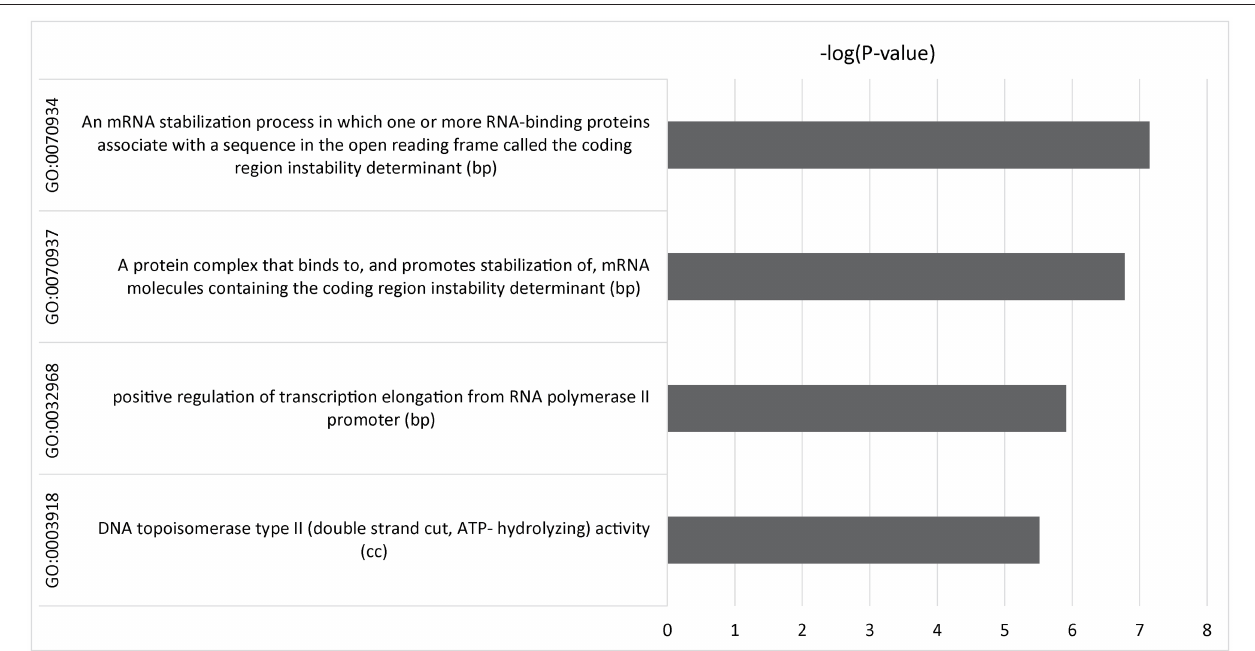
FIGURE 3 | Multimarker analysis of GenoMic annotation (MAGMA) output of significant gene sets after gene set analysis of 15,488 tests was performed and Bonferroni corrected. Relative GO terms are biological processes (bp) and cellular components (cc).